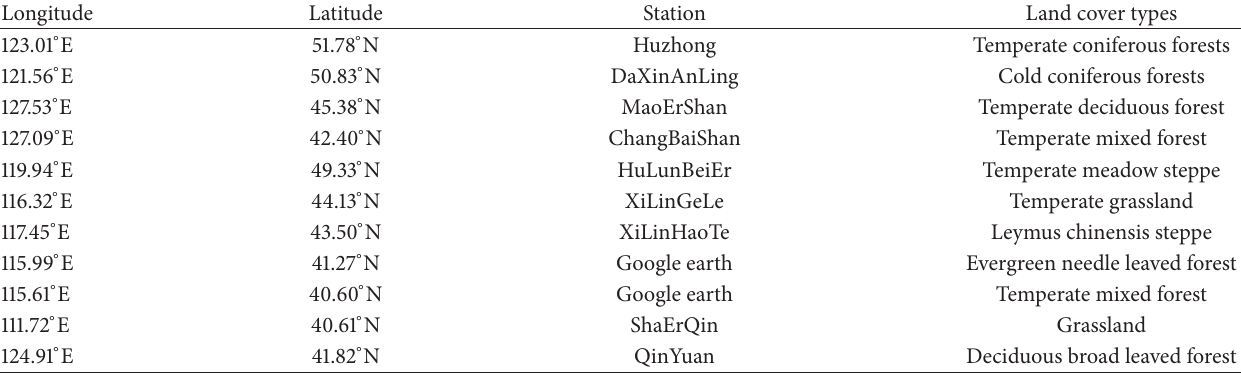
Table 6: The ground sample sites for validation over the farming-pastoral ecotone of North